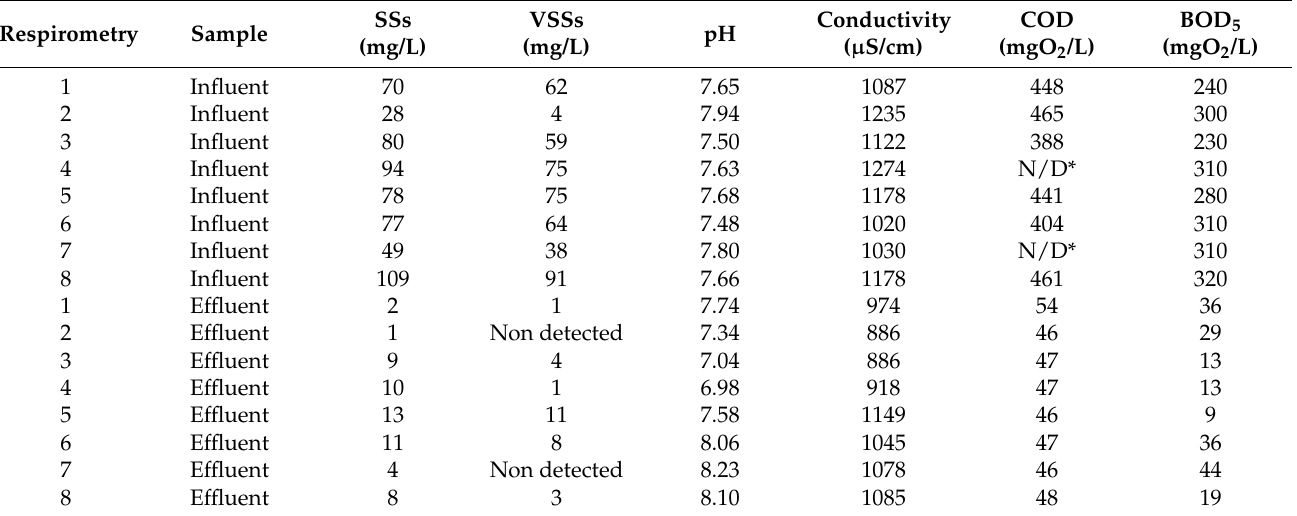
Table 2. Water characterization of phase-one and -two samples, where SSs—suspended solids; VSSs—volatile suspended solids; MLSSs—mixed liquor suspended solids; MLVSSs—mixed liquor volatile suspended solids; COD—chemical oxygen demand; and BOD 5 —five-day biochemical